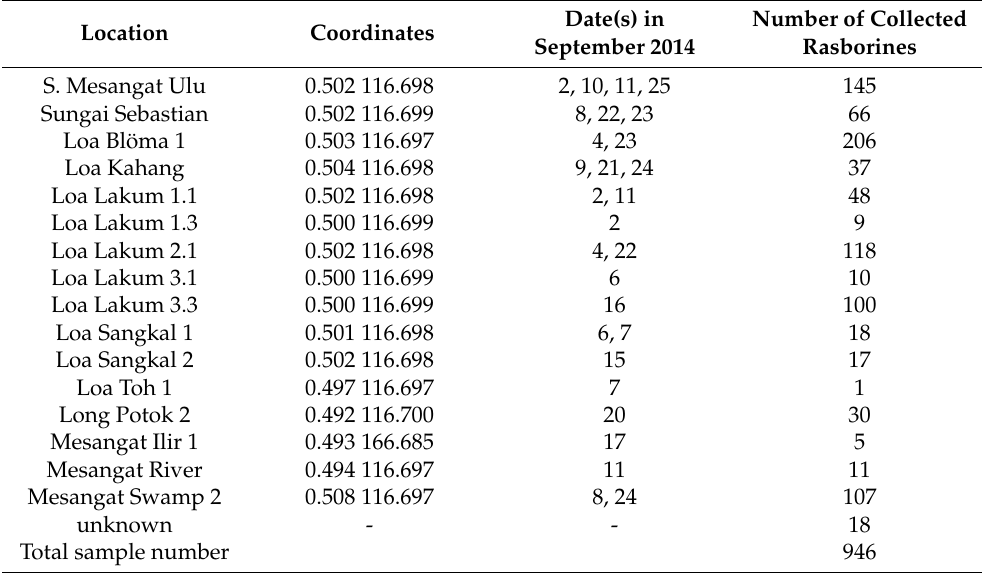
Table 1. Sixteen sampling locations including coordinates (latitude, longitude), date(s), and number of rasborine specimen collected per